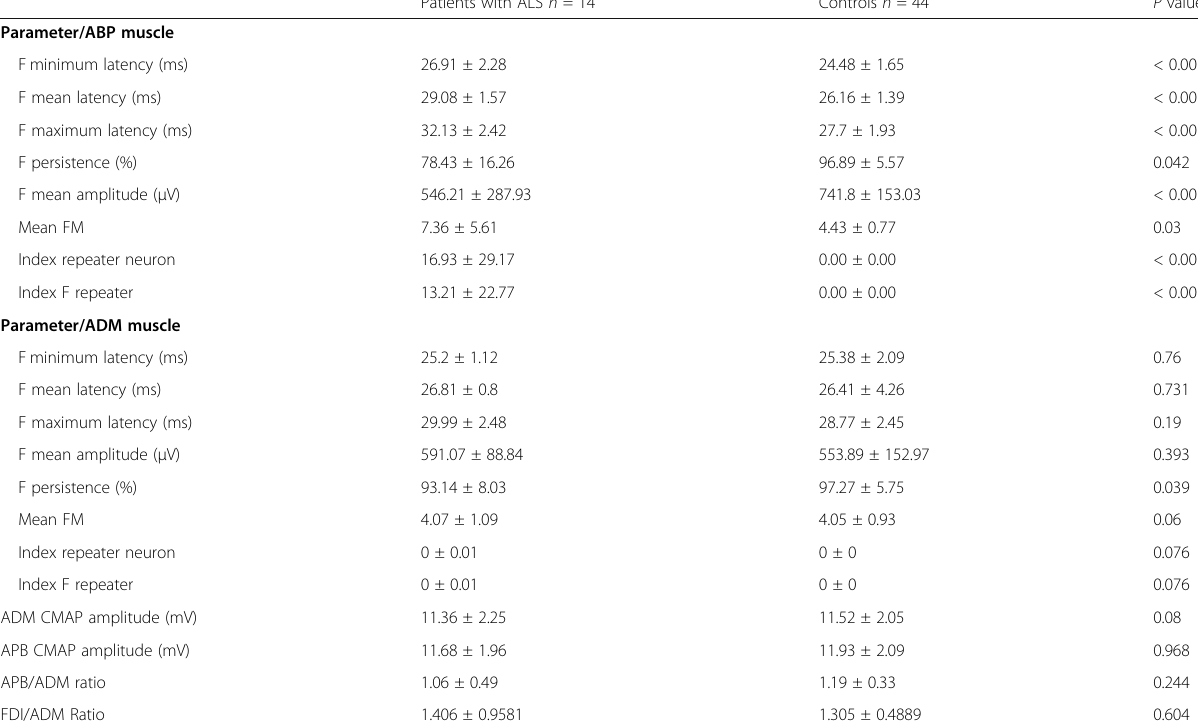
Table 6 F wave parameters in limb-onset of patients with ALS without pyramidal signs and hand muscle wasting and controls Patients with ALS n =